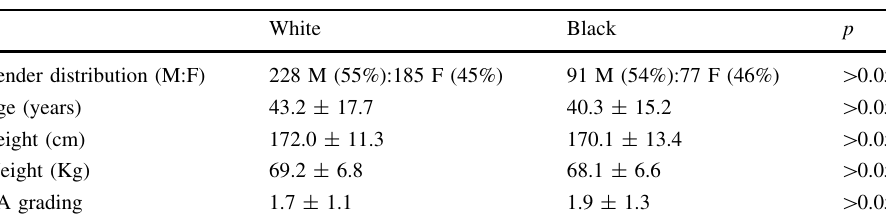
Table 1 Demographic data in white and black subjects